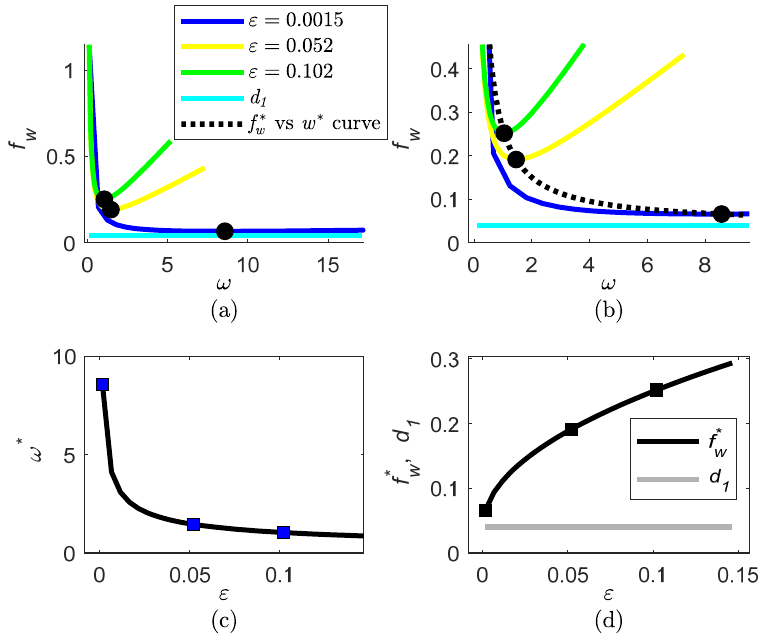
Figure 5. Effect of the observer parameters ε , ω on the f w function (19) for estimation of the specific growth rate µ : ( a ) f w as a function of ω for several ε values; ( b ) detail of f w as a function of ω for several ε values, indicating the minimum point; ( c ) values of ω ∗ as a function of ε , indicating the points for the ε values considered in subfigure a; ( d ) values of f ∗ w as a function of ε , indicating the points for the ε values considered in subfigure a.